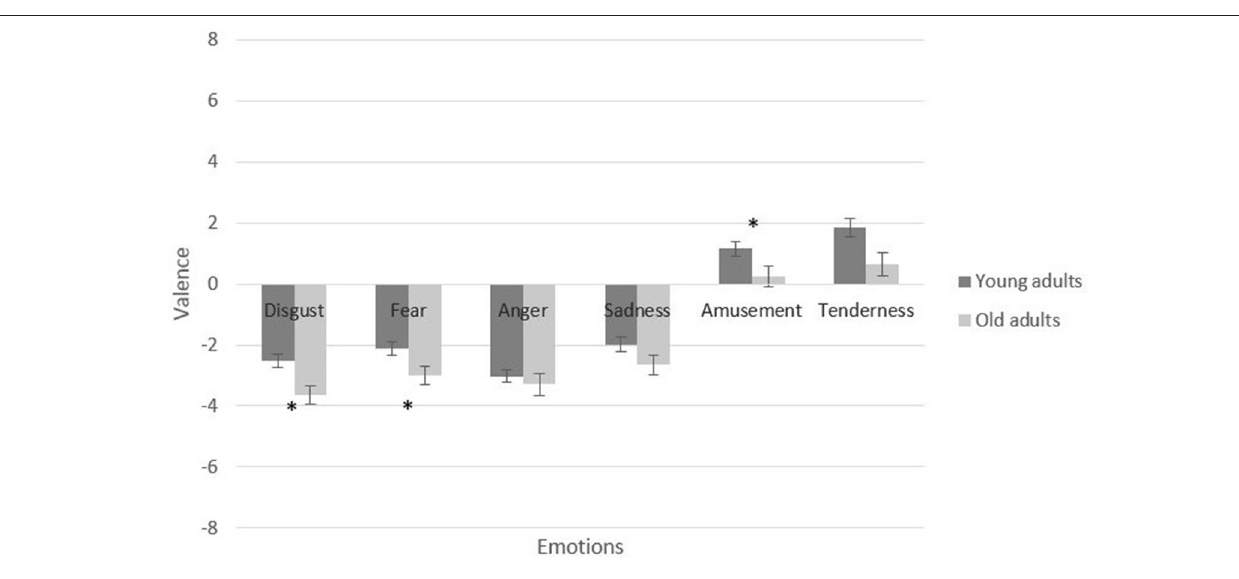
reported higher levels of valence than the young adults [ F (1,119) = 4.33, p = 0.039, partial η 2 =